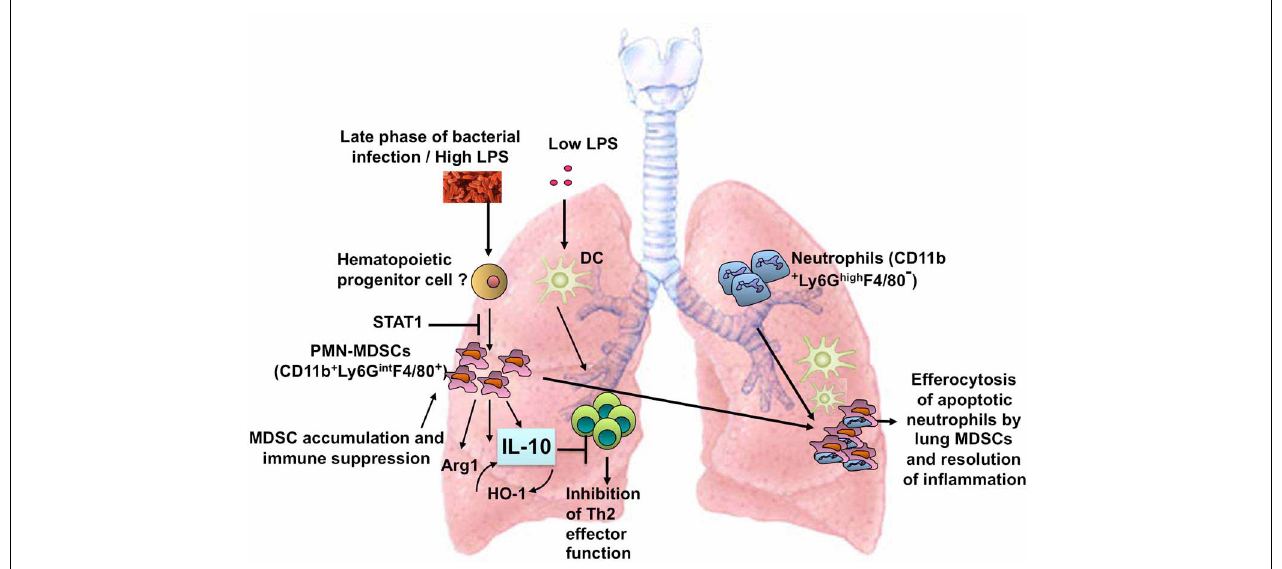
FIGURE 1 | Induction of MDSCs in the lung in response to a high dose of LPS or bacterial infection. The lung MDSCs express Arg1 and produce IL-10 and suppress Th2 effector function in the context of allergic airway inflammation and phagocytose apoptotic neutrophils during bacterial pneumonia.